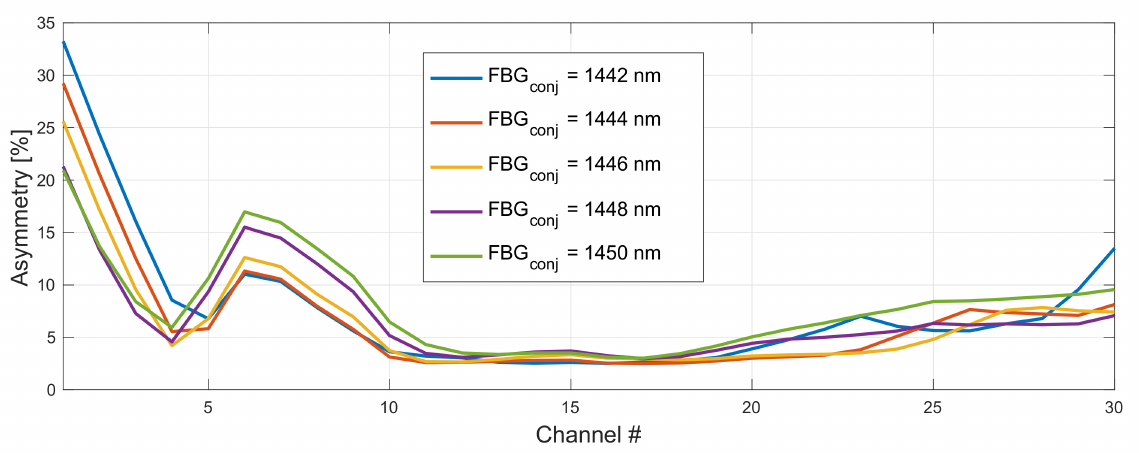
Figure 4. Impact of a FBG choice on asymmetry performance in 191–197 THz grid. Wavelength of a FBG for original WDM grid was set to 1462 nm and FBG for the conjugated copy was varied from 1442–1450